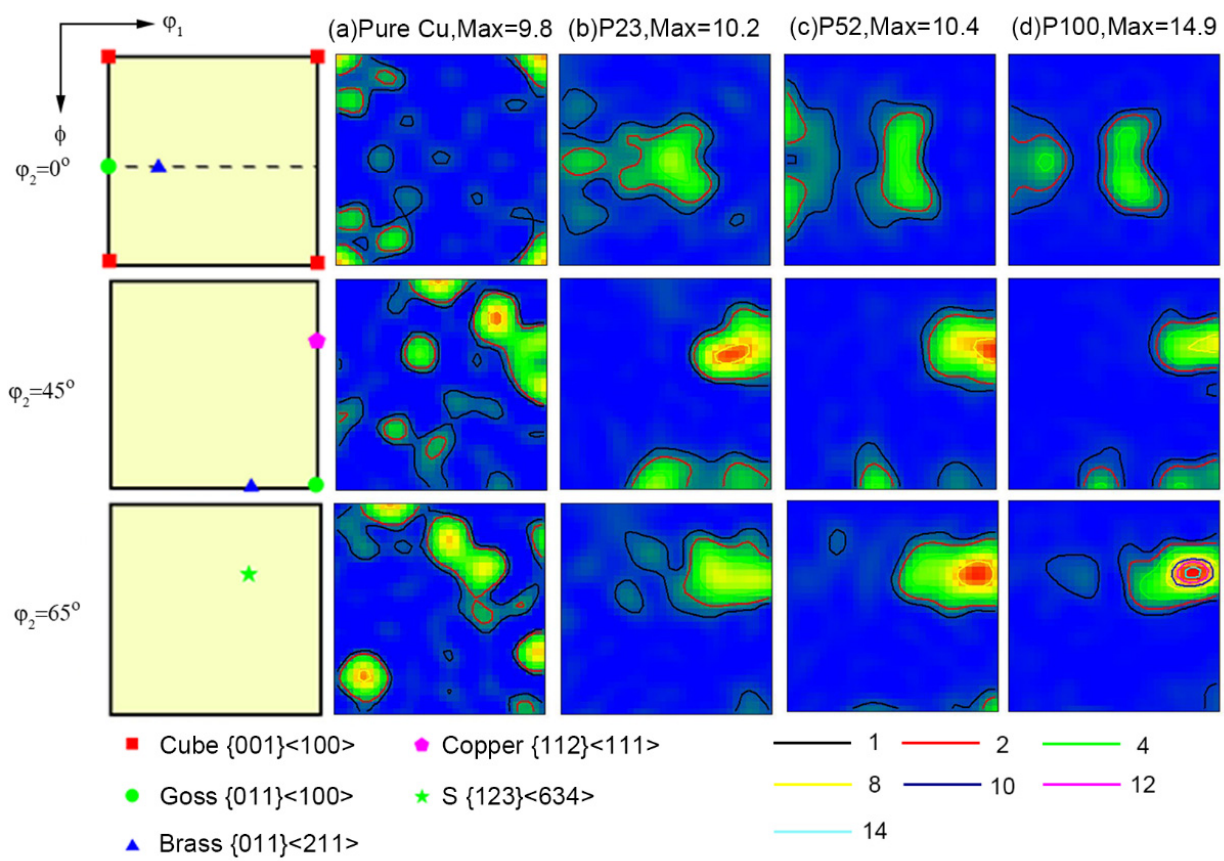
Figure 4. ODF sections of ϕ 2 = 0 ◦ , ϕ 2 = 45 ◦ and ϕ 2 = 65 ◦ of the Cu specimens intermediate annealed at 500 ◦ C for 5 min, ( a ) pure Cu, ( b ) P23, ( c ) P52, ( d ) P100, respectively.